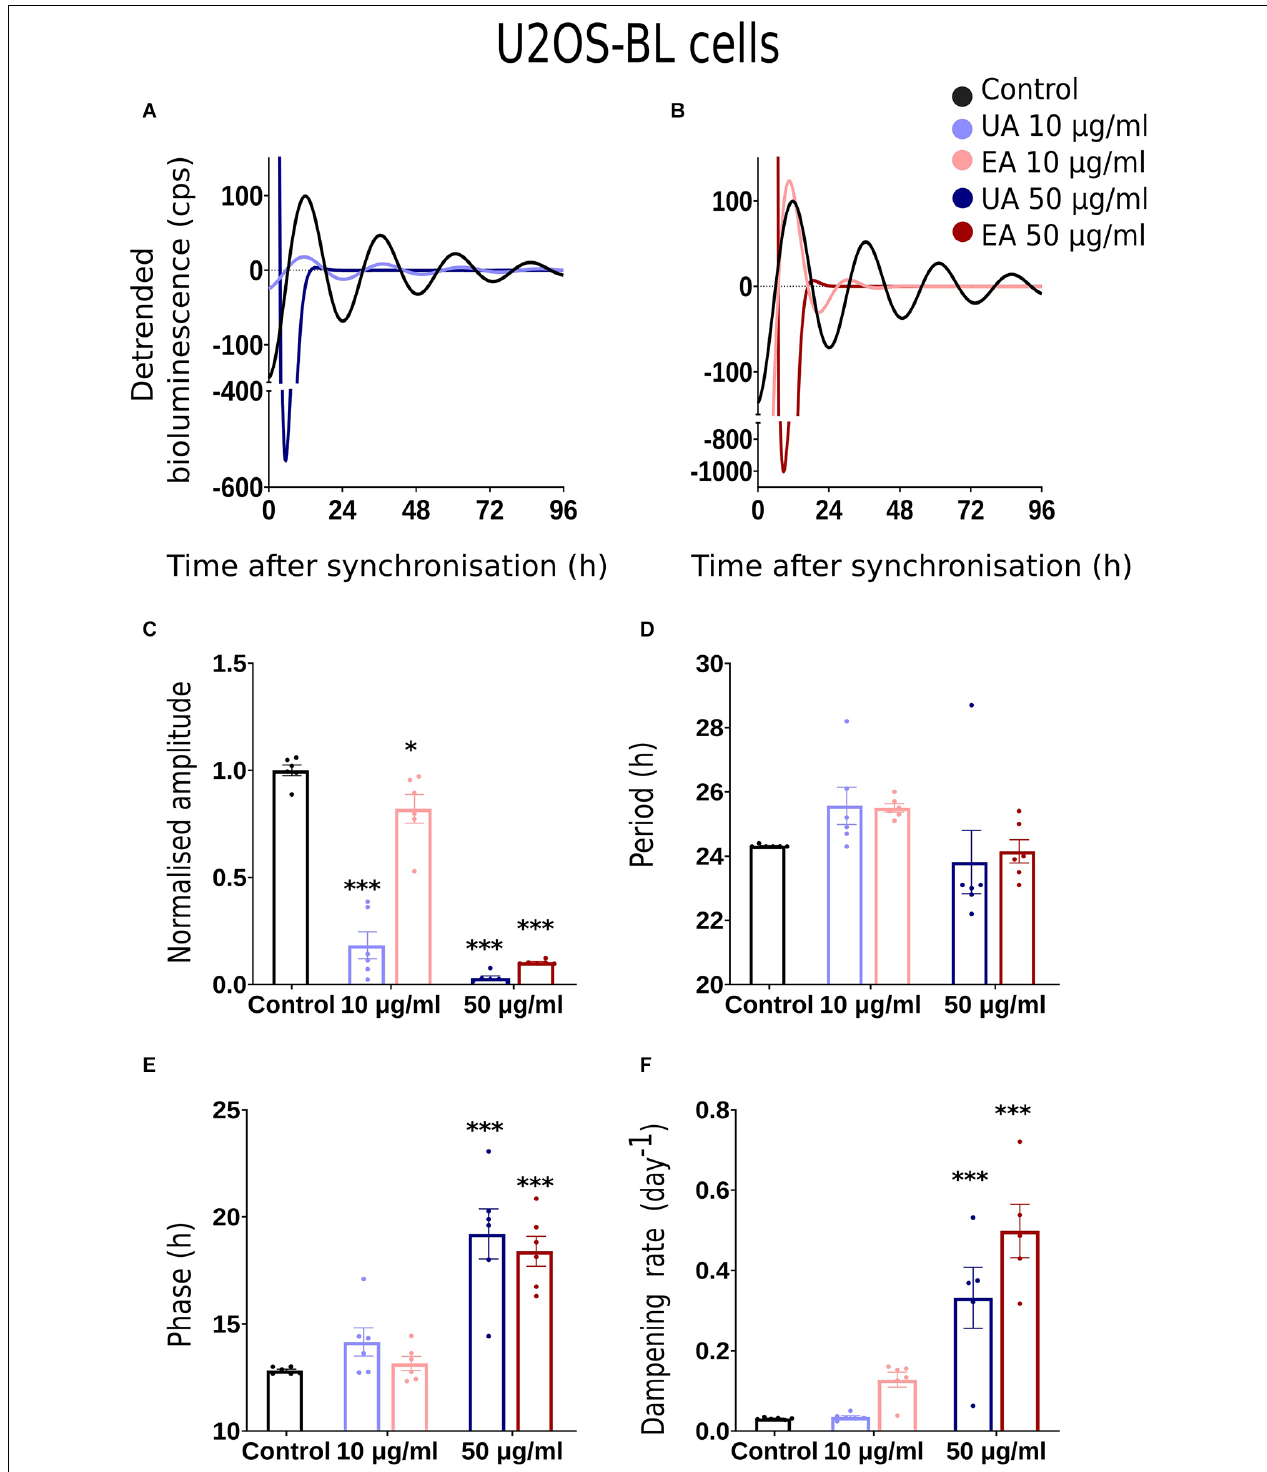
FIGURE 3 | Effects of lichenized secondary metabolites on circadian luminescence rhythms of U2OS-BL cells. Representative curve fits of Bmal1:luc luminescence rhythms in U2OS cells after treatment with different doses of usnic acid ( A , UA/Blue) or evernic acid ( B , EA/Red). Amplitude (C) , Period (D) , Phase (E) , and Dampening effects (F) on bioluminescence rhythms in U2OS cells after treatment with EA (10 or 50 µ g/ml; red) or UA (10 or 50 µ g/ml; blue) vs. solvent control (PBS/ DMSO; black). Single measures are shown; error bars indicate means ± SEM ( ∗ p < 0.05, ∗∗∗ p < 0.001; 2-way ANOVA with Tukey’s post-test).